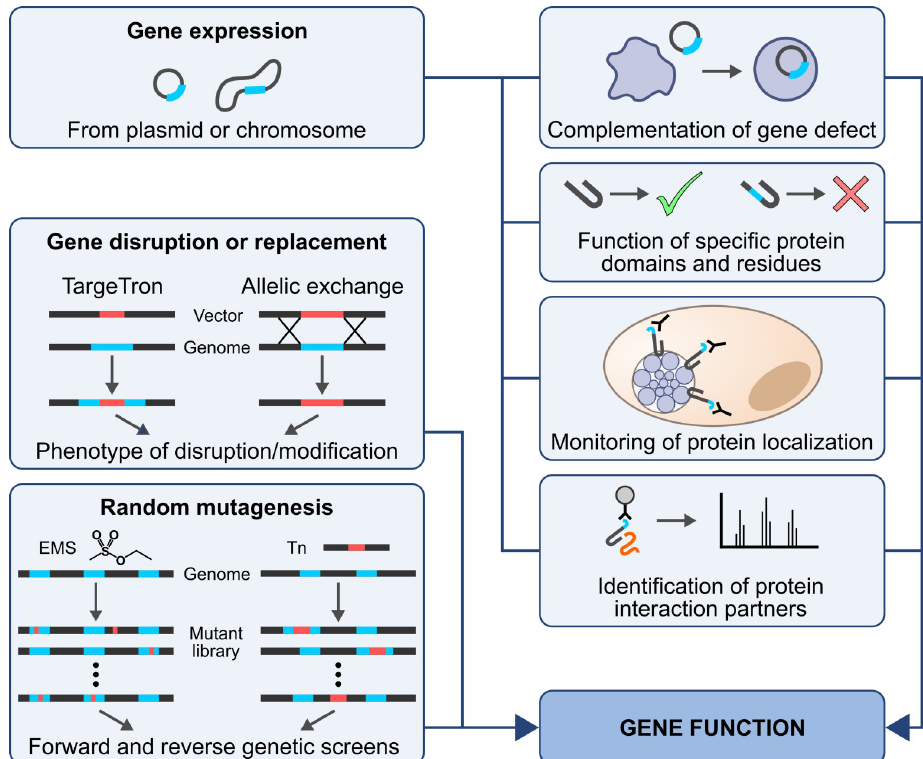
Fig 2. The benefits of a versatile genetic toolbox in the exploration of gene